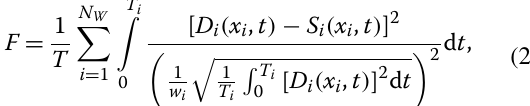
Table 1 List of analyzed events. Source : JMA. M are sourced from the JMA CMT catalog Event no. Date and Longitude, latitude, time (JST) depth